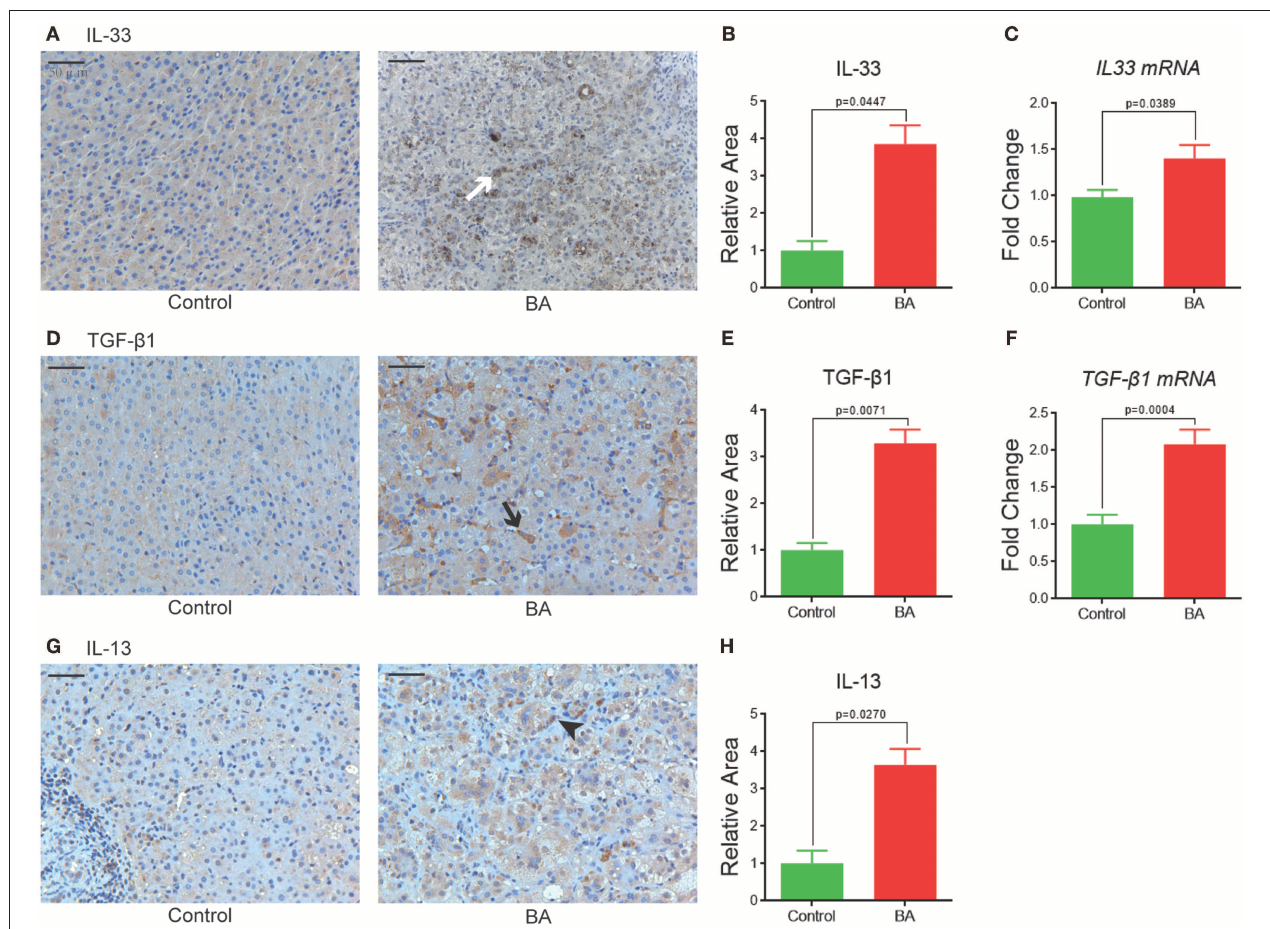
FIGURE 1 | IL-33, TGF- β 1, and IL-13 expressions in BA livers. (A) IL-33 expression in control and BA livers, shown as brown positive staining (white arrow). Quantification of IL-33 expression by IHC (B) , and qPCR (C) . (D) TGF- β 1 expression in control and BA livers, positive staining shown as black arrow. Quantification of TGF- β 1 by IHC (E) and qPCR (F) . (G,H) IL-13 IHC and quantitation in control and BA livers, positive staining shown as black arrowhead.